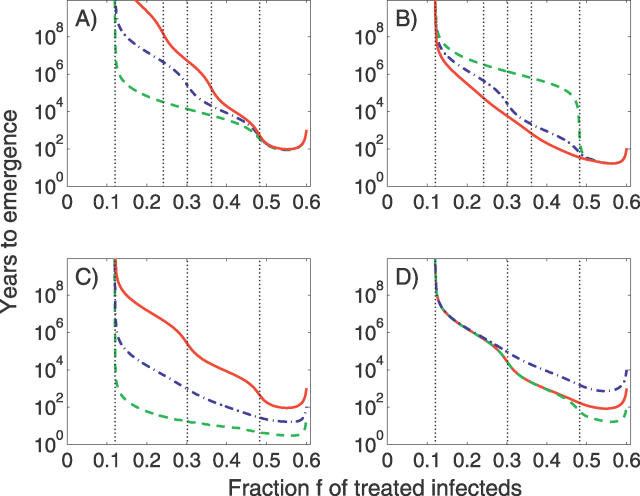
Years until Emergence Occurs as a Function of Treatment(A) All conversion probabilities are μi = 10−3. The green dashed line shows a situation with two resistant strains with fitness 60% and 90% that of the sensitive strain. The blue dash-dotted line shows three resistant strains with fitness 60%, 75%, and 90%, and the red solid line shows four resistant strains with fitness 60%, 70%, 80%, and 90%.(B) Same number of strains and fitness levels as (A) but the product of all conversion probabilities is kept the same. We choose μt = 10−2 for all three cases and μ
1 = 10−6 for the two-strain scenario (dashed green line), μ
1 = μ
2 = 10−3 for the three-strain scenario (dash-dotted blue line), and μ
1 = μ
2 = μ
3 = 10−2 for the four-strain scenario (solid red line).(C) Three resistant strains with fitness of 60%, 75%, and 90%. Conversion rates are μi = 10−1 (dashed green line), μi = 10−2 (dash-dotted blue line), and μi = 10−3 (solid red line).(D) Same as (C) but with conversion rates μt = 10−2, μ
1 = μ
2 = 10−3 (dashed green line), μt = 10−4, μ
1 = μ
2 = 10−2 (dash-dotted blue line), and μt = μ
2 = 10−3, μ
1 = 10−2 (solid red line).